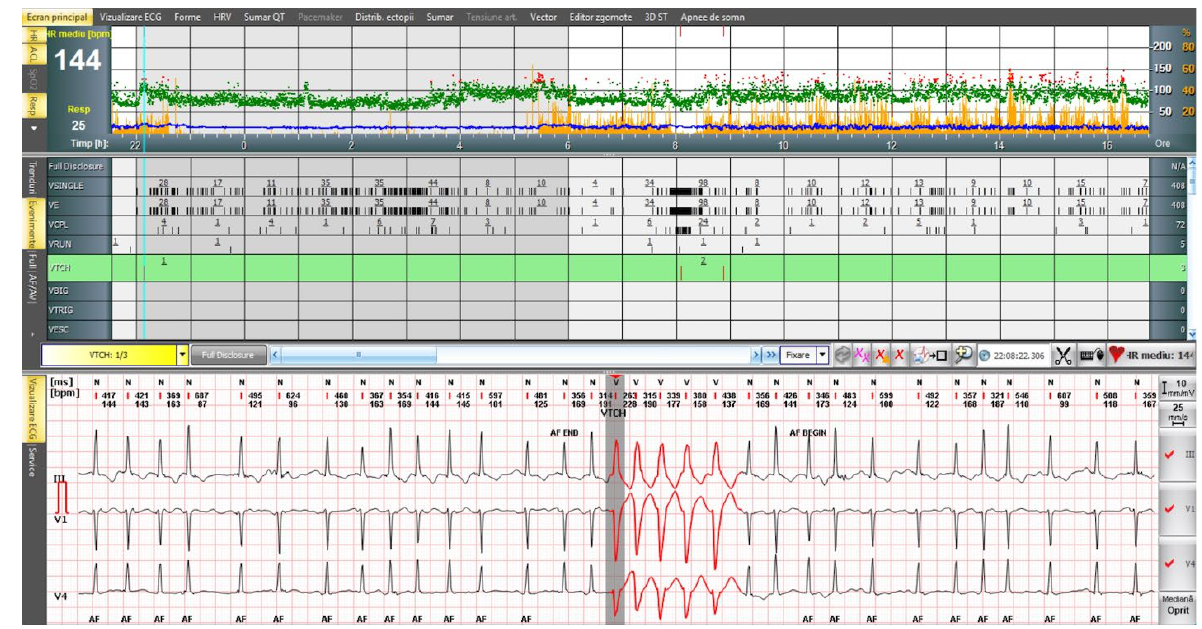
Figure 4. Case 1— ECG monitoring showing atrial fibrillation and non -sustained ventricular Figure 4. Case 1—ECG monitoring showing atrial fibrillation and non-sustained ventricular tachy- tachycardia (AF— atrial fibrillation, VTCH —ventricular tachycardia). QRS axis changes, with wide cardia (AF—atrial fibrillation, VTCH—ventricular tachycardia). QRS axis changes, with wide QRS QRS complex. Biomedicines 2023 , 11 , x FOR PEER REVIEW complex.